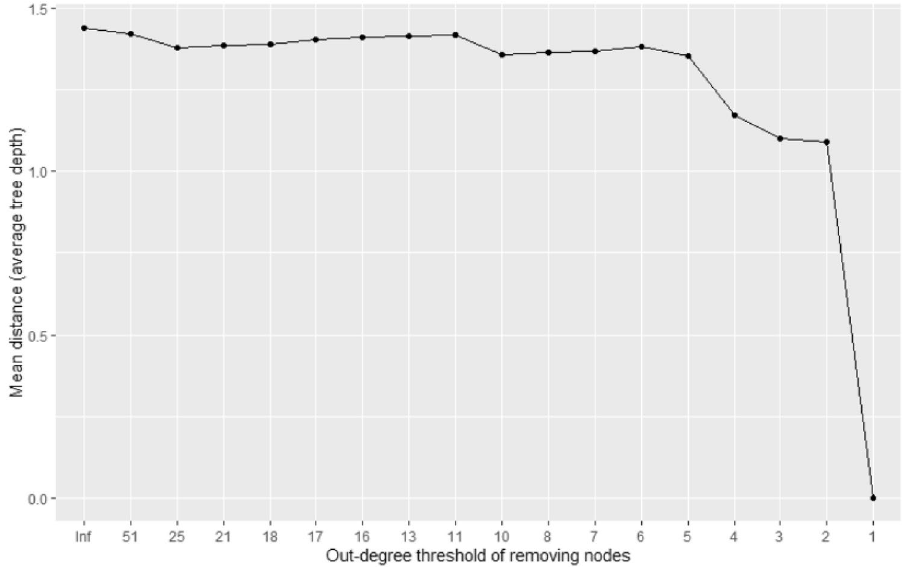
Figure 5. The change in the network’s mean distance as we remove the nodes whose out-degree is equal to or larger than the threshold.